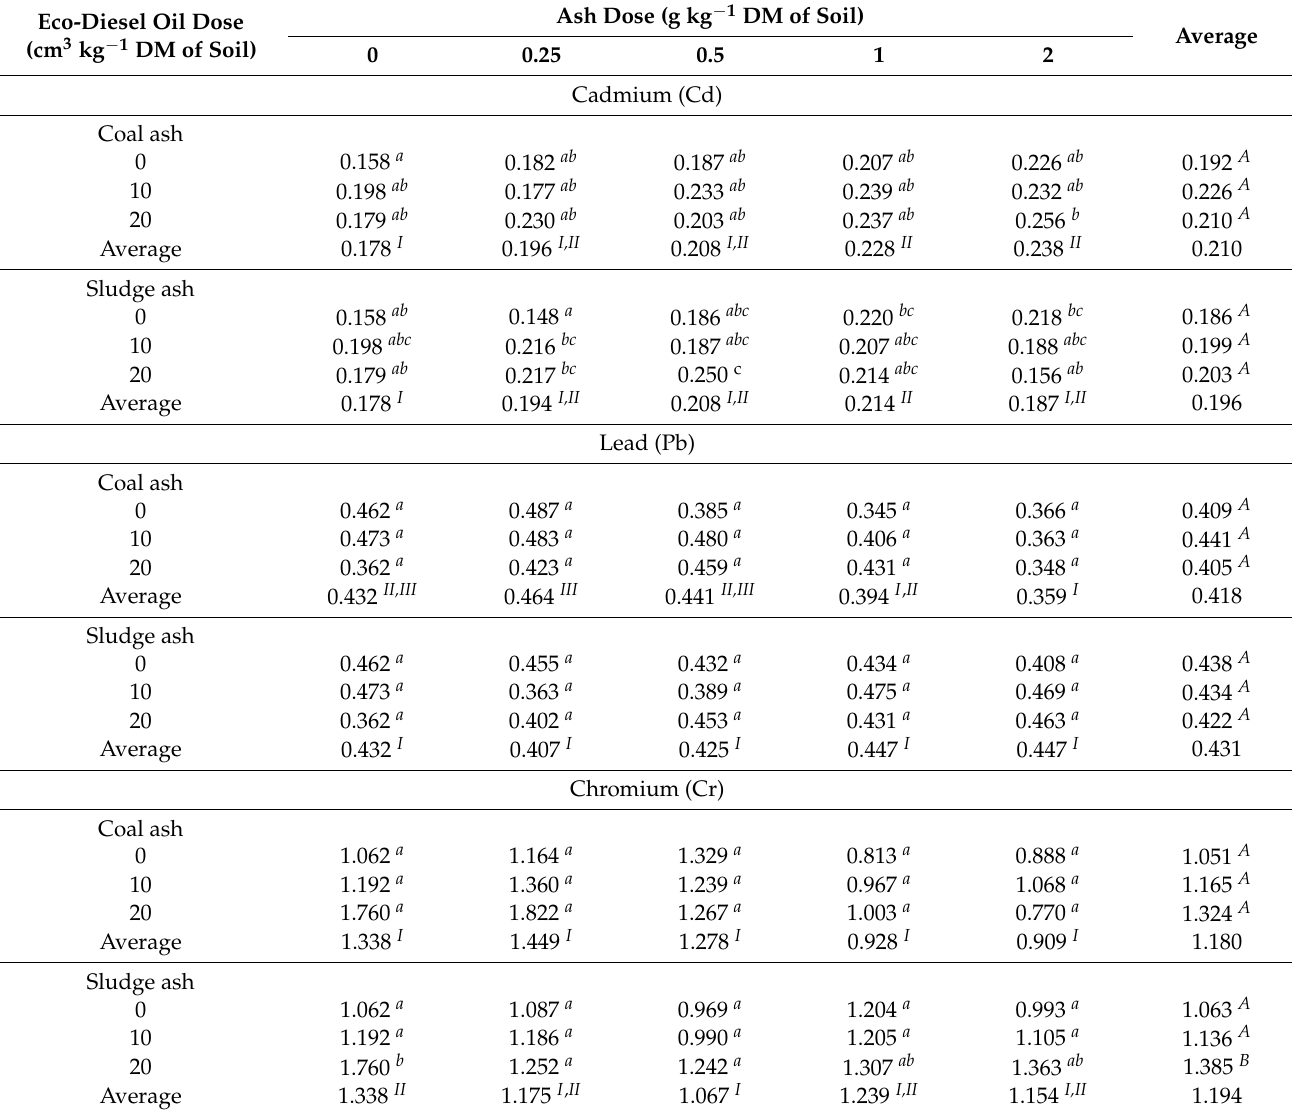
Table 1. Content of cadmium (Cd), lead (Pb), and chromium (Cr) in above-ground parts of maize— Zea mays L. (mg kg − 1